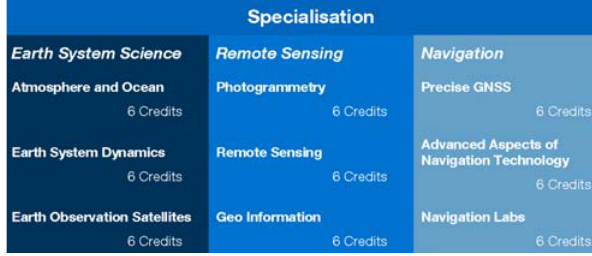
Table 2. Specialisation options in the third semester: An overview of the three specialist fields with their